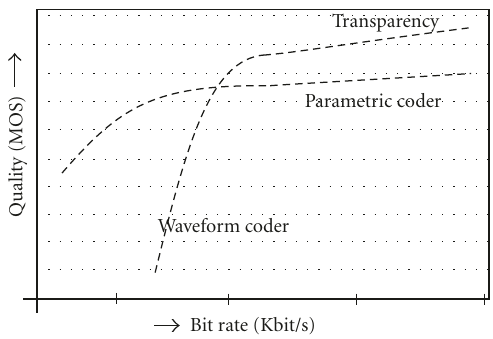
Figure 1: Schematic view of the quality/bit rate tradeo ff for para- metric and waveform coding